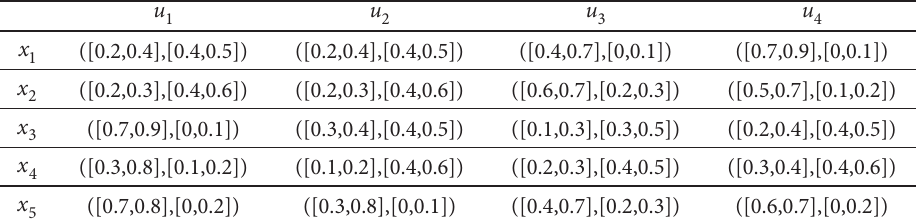
Table 5. Interval-valued intuitionistic fuzzy decision matrix (3) R